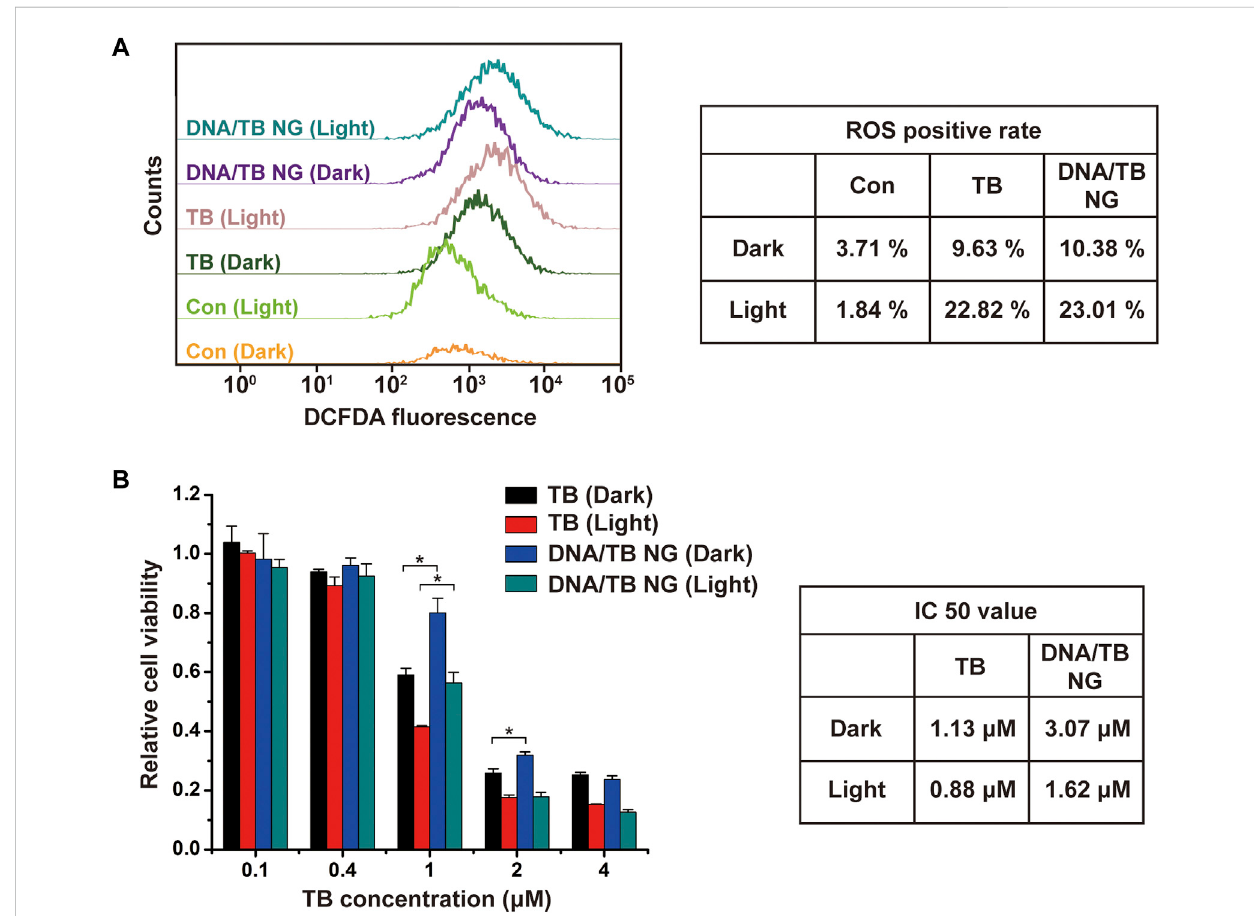
FIGURE 5 Comparison ofPDTeffectsofTBandDNA/TBNGonMCF-7cells. (A) FACSanalysisofROSincells. TheTBconcentrationwas2 µM. (B) Cytotoxicity of TB and DNA/TB NG with or without light